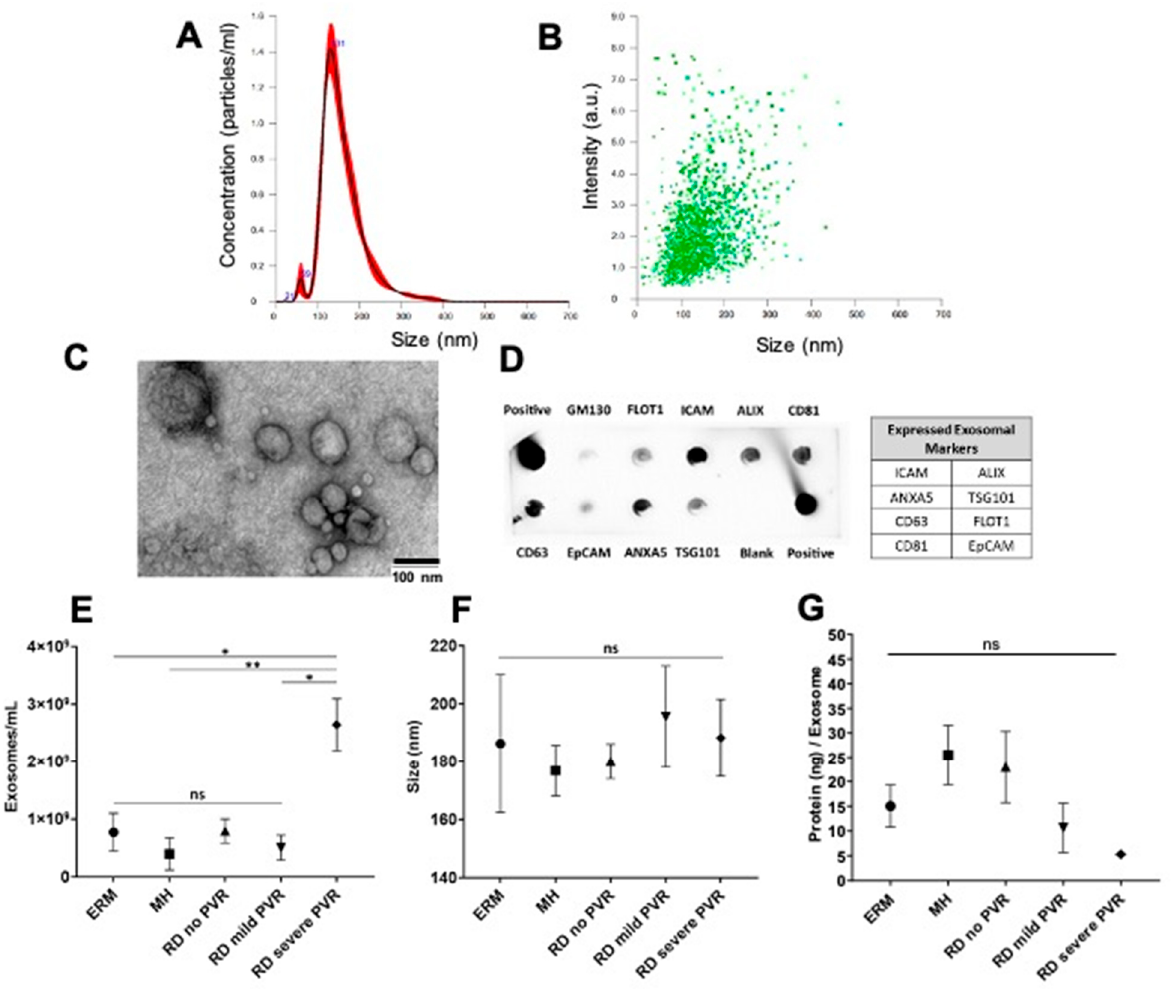
Figure 2. Characterization of exosomes from vitreous humor (VH). ( A , B ) The average peak size of exosome particles (131 nm) and average number of particles of exosome (2.42 × 10 9 /mL) were determined by nanoparticle tracking analysis (NAT). ( C ) The morphology of exosomes was confirmed by transmission electron microscopy (TEM). ( D ) Exosome markers including FLOT1, ICAM, ALIX, EpCAM, ANXA5, TSG101, CD81, and CD63 were confirmed by exosome detection antibody array. ( E – G ) The number of exosome particles were increased only in the RD with severe PVR group compared with the control and RD without or with mild PVR groups. The sizes of exosomes and the protein concentrations of the exosomes were similar amongst the groups (mean ± SEM; *, p < 0.05; **, p < 0.01).